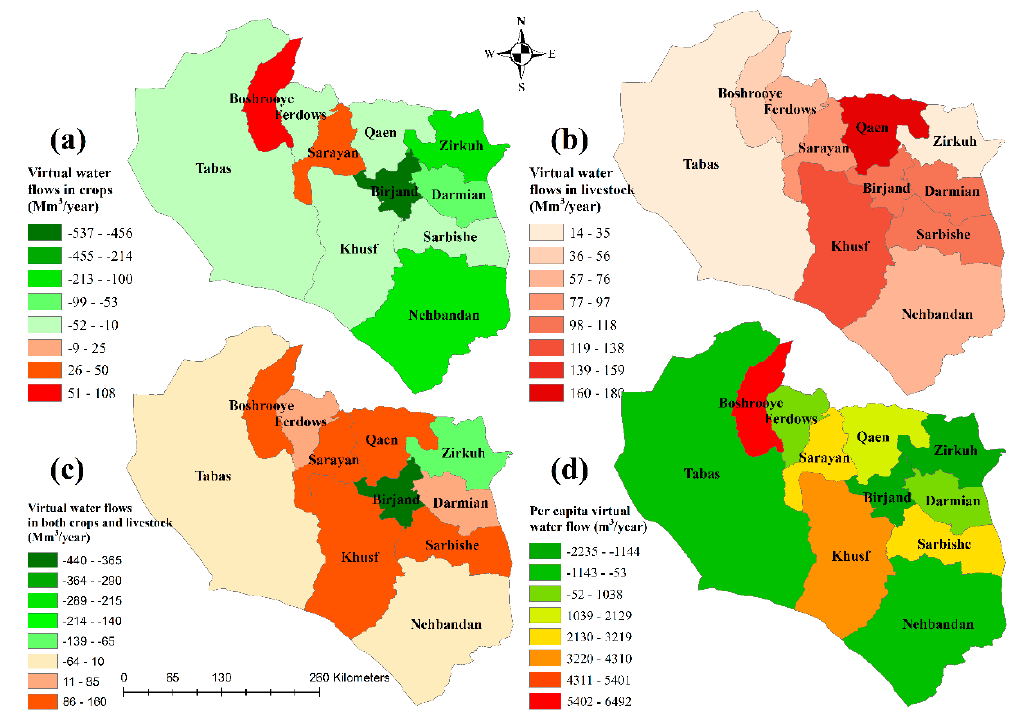
Figure 5. Virtual water flows associated with ( a ) crops; ( b ) livestock; ( c ) both of crops and livestock; and ( d ) per capita virtual water flows. Table 3. Ranking the counties in virtual water import and export (Mm 3